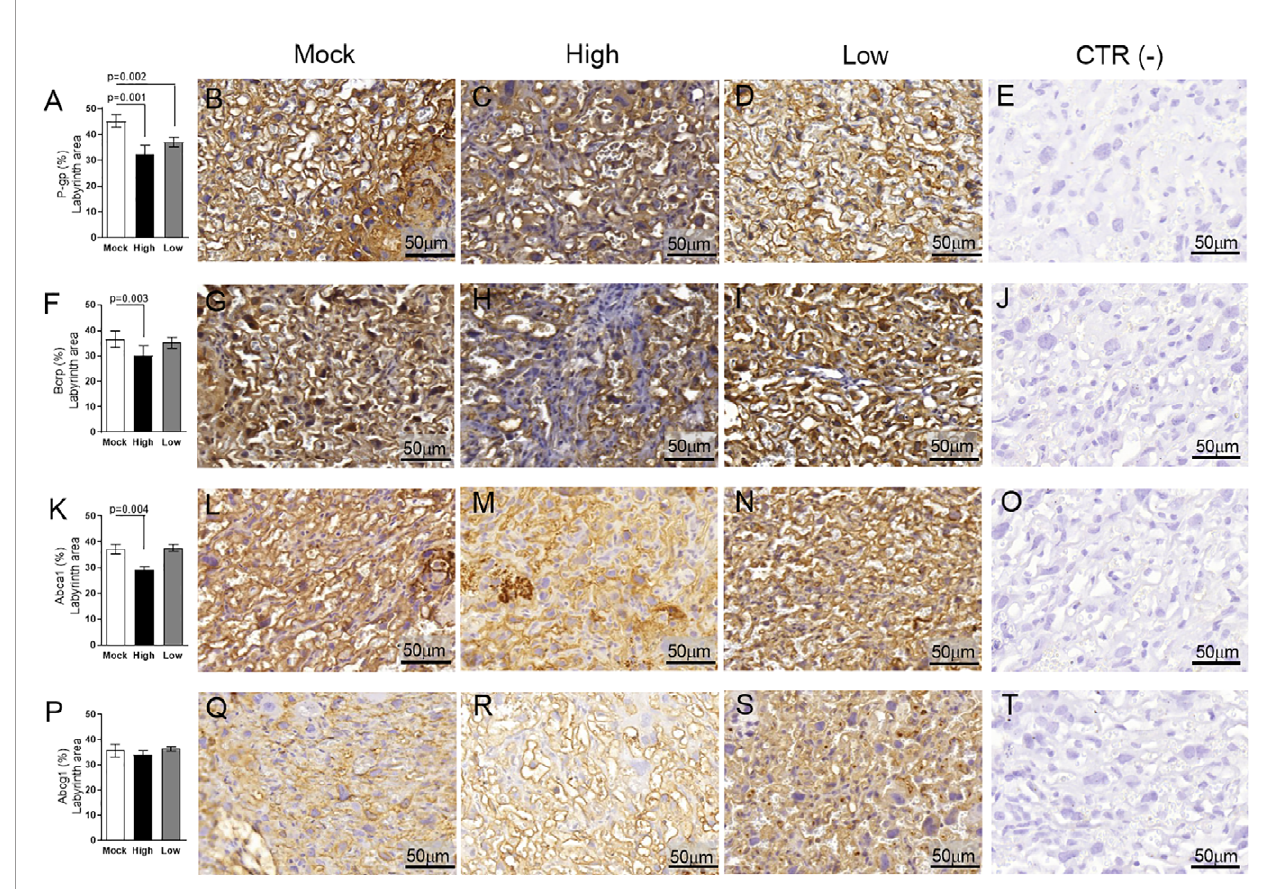
FIGURE 8 | ZIKV infection decreases P-gp, Bcrp and Abca1 expression in the placental Lz of infected mice in the ICompetent groups. A total of 180 digital images (40X) randomly captured from the whole labyrinth zone (Lz) of each placenta per dam were evaluated. Immunolabeling in each digital image was quanti fi ed by calculating the percentage area of the total stained labyrinthine tissue after exclusion of the total negative space. (A) Quanti fi cation and (B – D) representative photomicrographs of P- gp staining in the Lz of ICompetent (n=6 placentae from 6 independent dams/group) placenta. (F) Quanti fi cation and (G – I) representative photomicrographs of Bcrp staining in the Lz of ICompetent (n=6 placentae from 6 independent dams/group) placenta. (K) Quanti fi cation and (L – N) representative photomicrographs of Abca1 staining in the Lz of ICompetent (n=6 placentae from 6 independent dams/group) placenta. (P) Quanti fi cation and (Q – S) representative photomicrographs of Abcg1 staining in the Lz of ICompetent (n = 6 placentae from 6 independent dams/group) placenta. (E, J, O, T) Negative controls. One-way ANOVA followed by Tukey ’ s post-test. The values are expressed as the mean ± SEM. Images were captured at 40X. Scale bar = 50